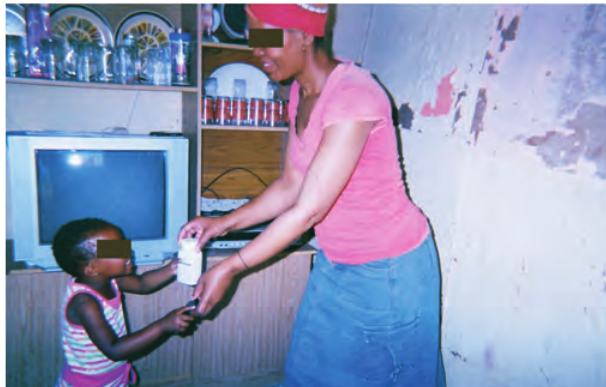
Fig. 1. The daughter of a patient reminds her mother to take her medication.